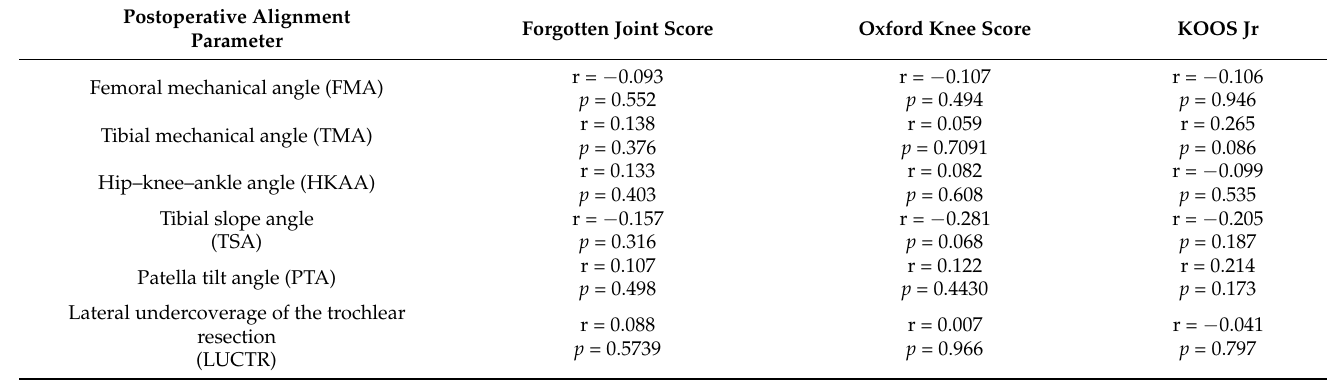
Table 4. The correlation coefficient (r) and significance between six postoperative radiographic parameters and the postoperative forgotten joint score, Oxford knee score, and KOOS